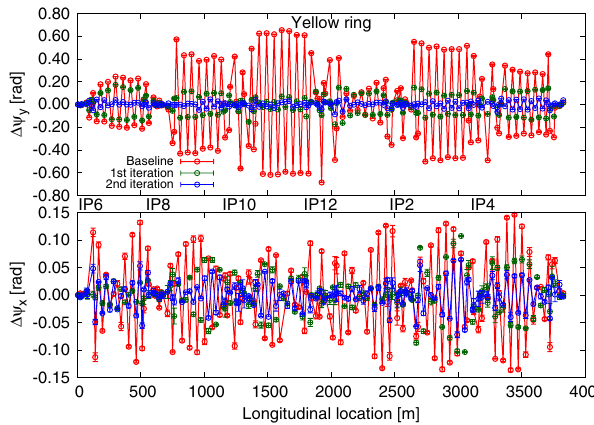
FIG. 10. Baseline and corrected horizontal (bottom) and vertical (top) relative phase-beat with error bars for the Yellow ring. The reduction of relative phase-beat after correction of beta-beat is evident.